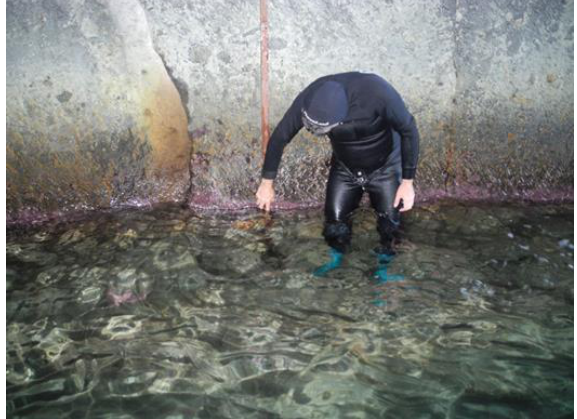
Figure 3. Direct measure by means of graduated stadia